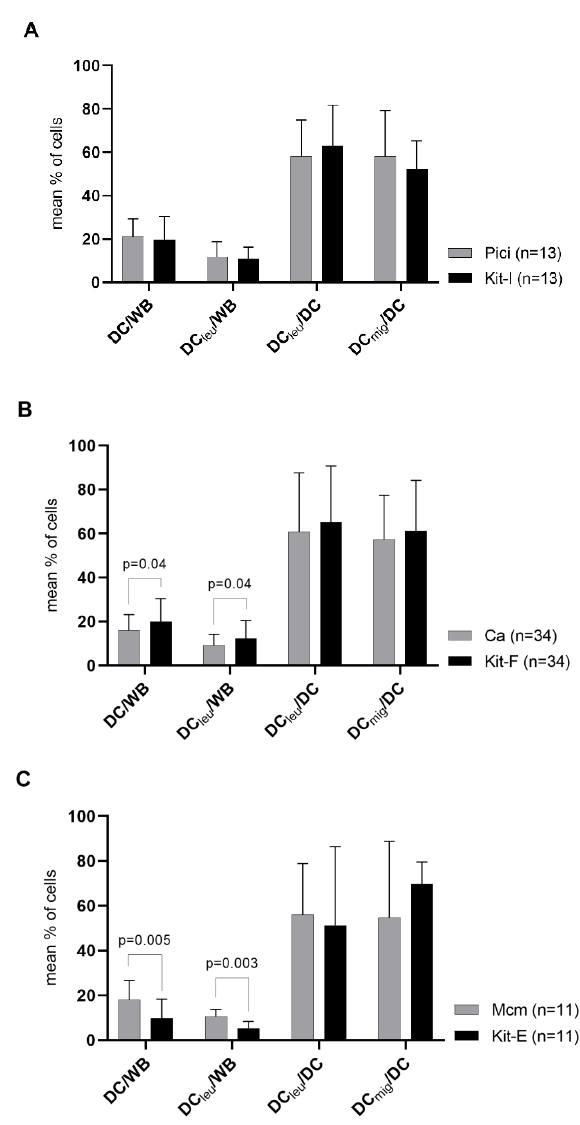
Figure 3. DC/DC leu -generation from leukaemic WB with standard (Ca, Mcm, Pici) and new DC/DC leu -generating protocols (kits). Given are the mean ± SD of DC/cells, DC leu /cells, DC leu /DC and DC mig /DC generated with Pici compared to Kit-I ( A ), Ca compared to Kit-F ( B ) and Mcm compared to Kit-E ( C ). Statistically significant differences ( p values < 0.05) (two-tailed t-test) are given.